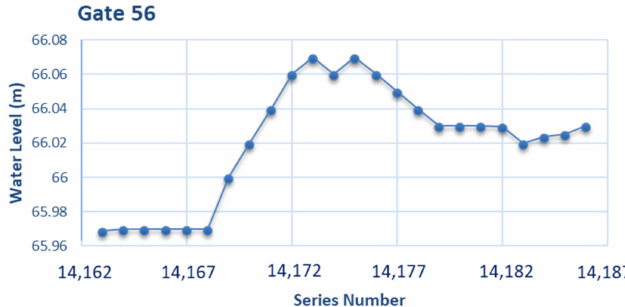
Figure 4. The change trend of water levels before gate